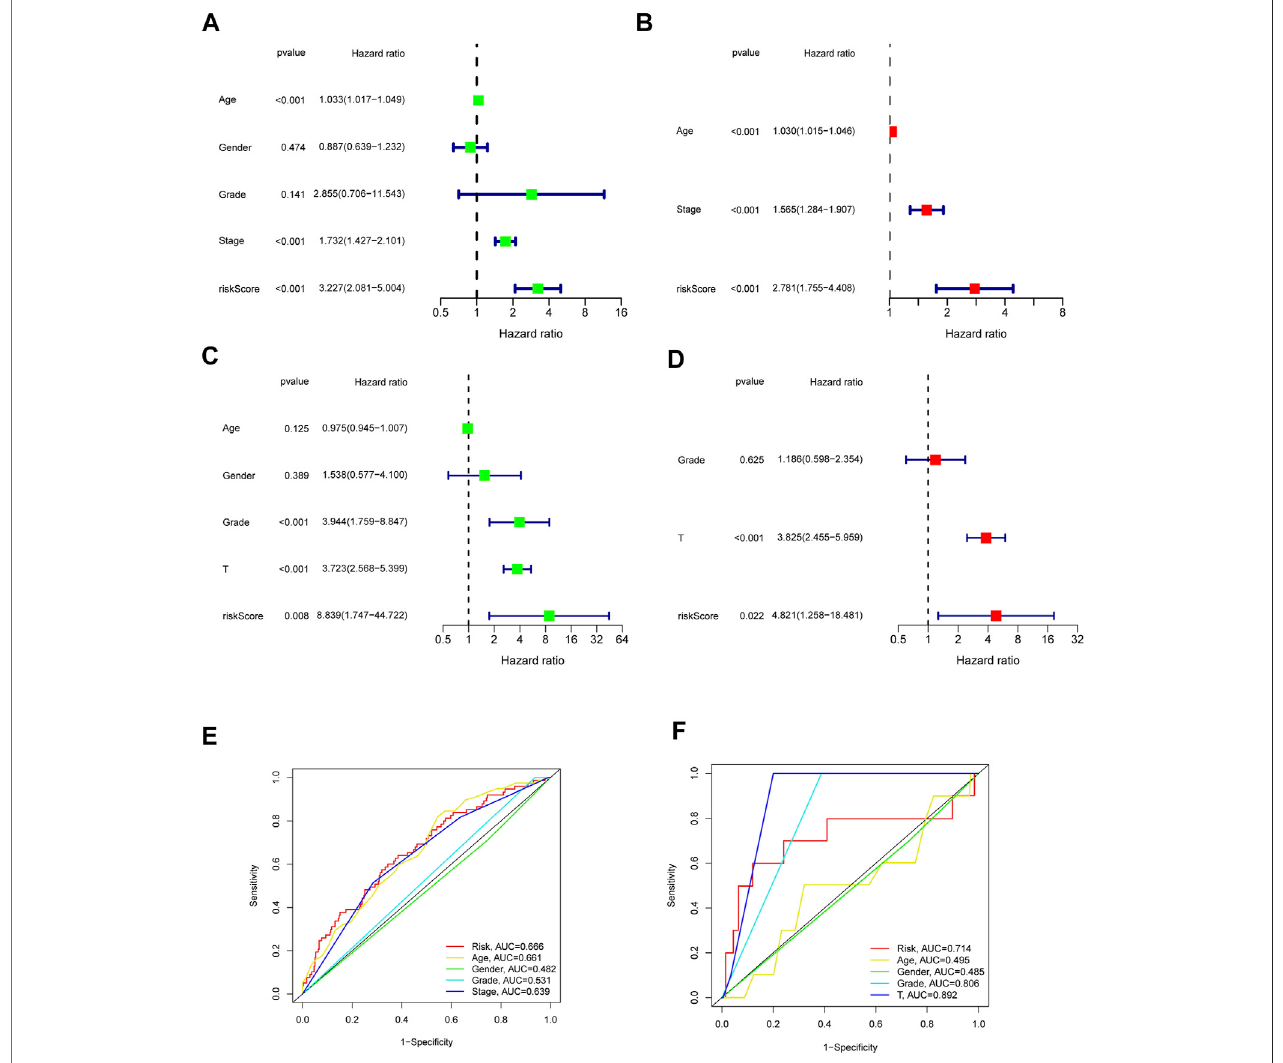
FIGURE 5 | Outcome of Cox regression analysis with regard to survival time in the TCGA cohort (A,B) , GSE32894 (C,D) . Time-dependent ROC curve (E,F) to compare the prognostic accuracy of risk score, age, gender, tumor stage, tumor grade, and T Stage.